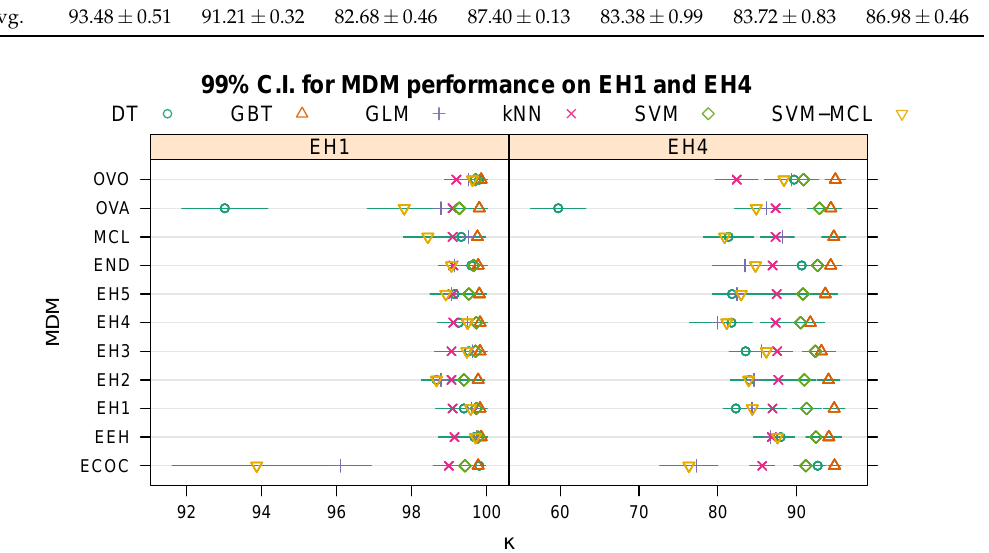
Figure 2. 99% confidence intervals (C.I.) for the effect of the multi-class decomposition method (MDM) on the Kappa statistic for the topmost dichotomy of EH1 (left) and EH4